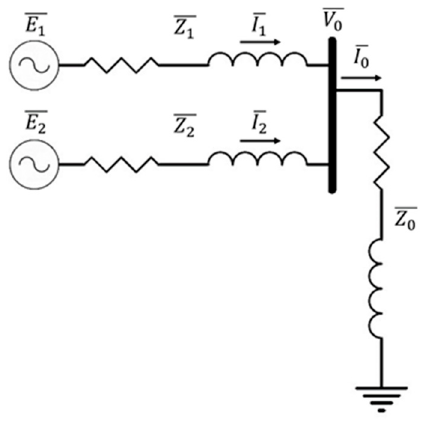
Figure 2. Schematic of a two parallel-connected inverters system.